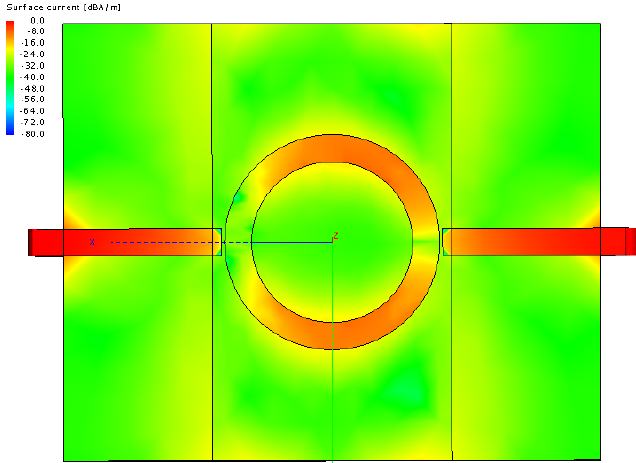
Figure 11. The simulated surface current.